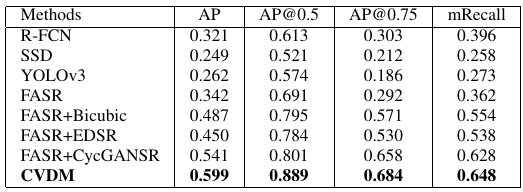
Table 7. Results on Potsdam vehicle dataset(IoU=0.5), compared with method in remote sensing.